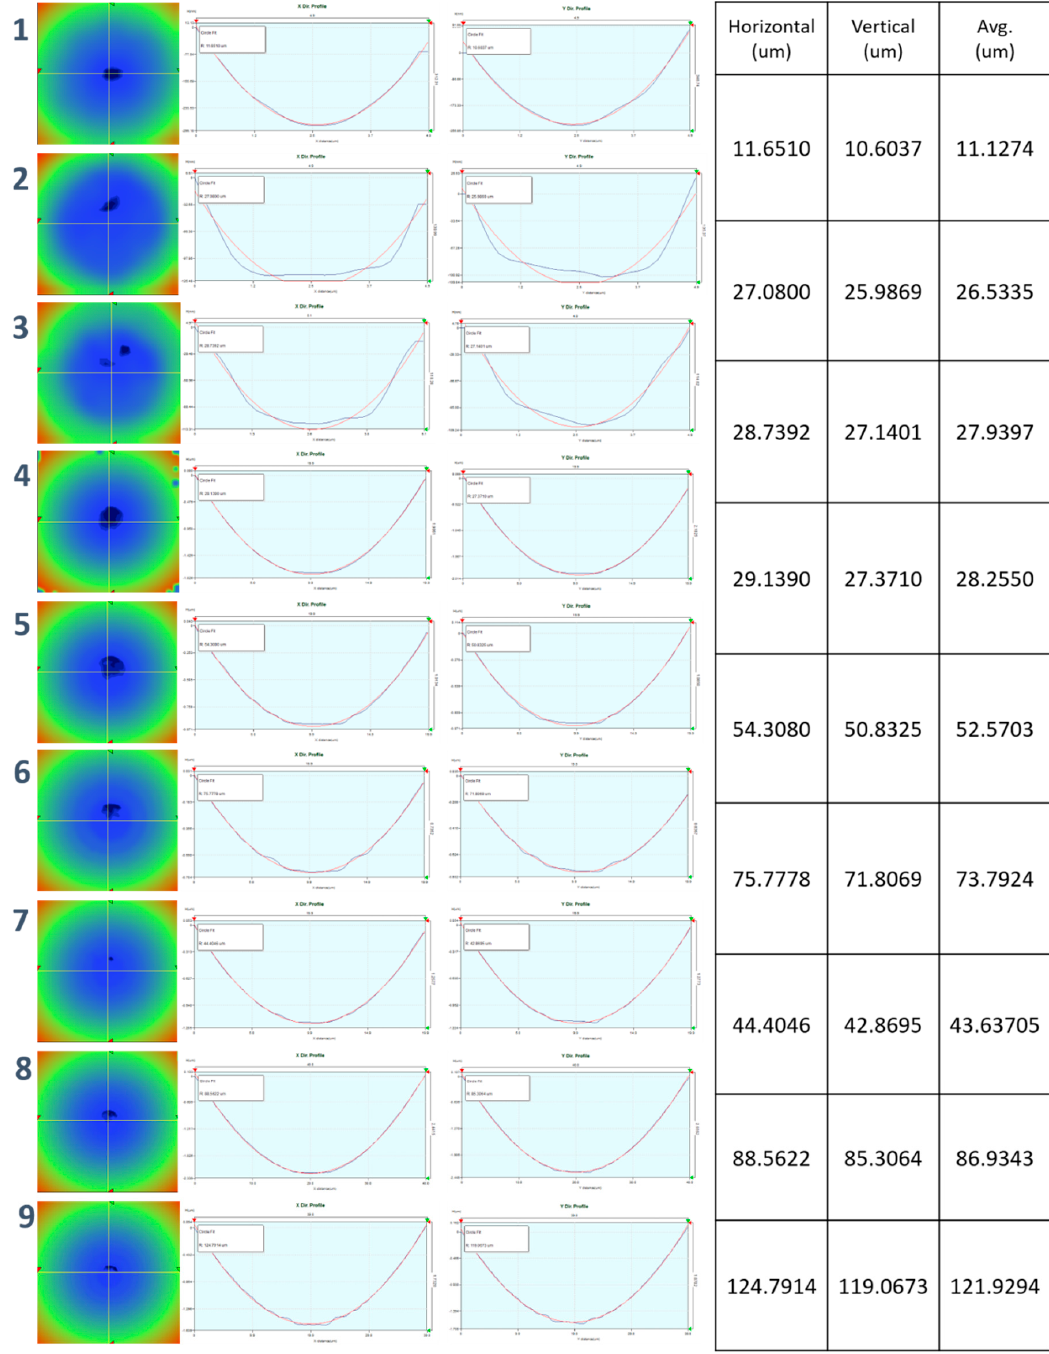
Figure A17. ROC measurement data for 5th final product replica (402).